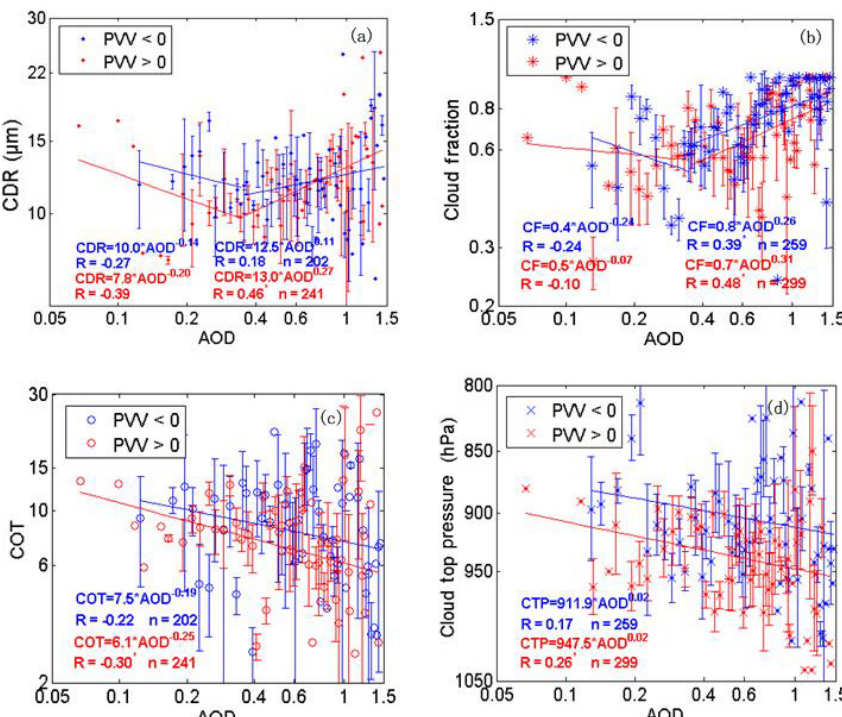
Figure 11. Scatter plots of cloud parameters versus AOD over YRD on log–log scale for cases of PVV<0 condition (blue) and mixed aerosol–cloud layers under high PVV>0 condition (red): (a) CDR, (b) CF, (c) COT and (d) CTP. The lines present the least-square fits, and the resulting relations are presented in each figure. The error bars indicate the statistical uncertainties as in Fig.